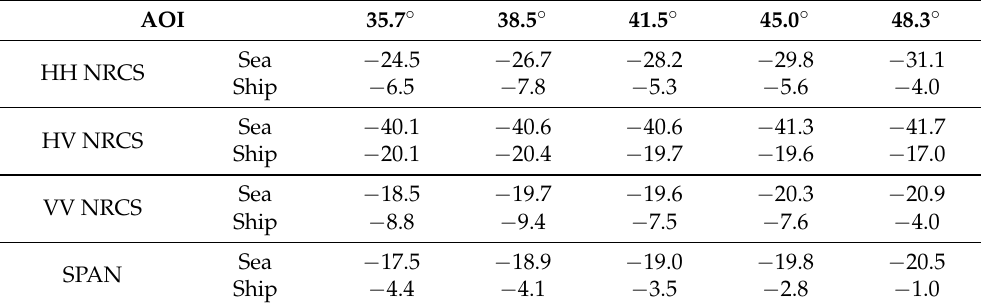
Figure 7. Average multi–polarisation NRCSs with respect to AOI. Dashed lines with circle markers and continuous lines with diamond markers refer to sea and ship ROIs, respectively, while black, red, and blue colours refer to HH, HV, and VV polarisation, respectively. The dB scale is adopted. Table 2. Mean values (in dB) of incoherent scattering descriptors, i.e., multi-polarisation NRCSs and SPAN, evaluated over both sea and ship ROIs at the five